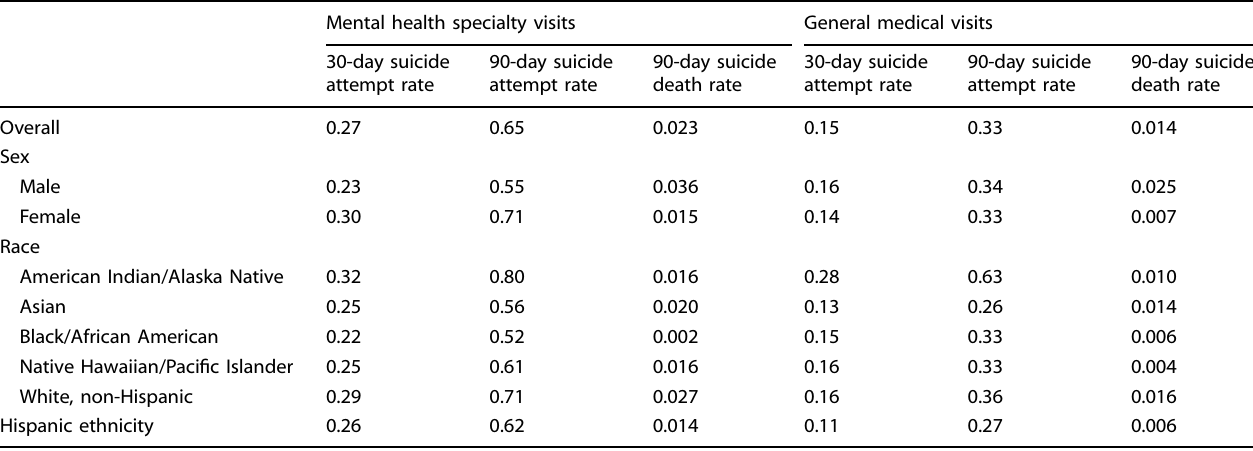
Table 2. Percentage of visits followed by a suicide attempt and death in validation sample for mental health specialty visits and general medical visits, overall and across racial and ethnic subgroups and